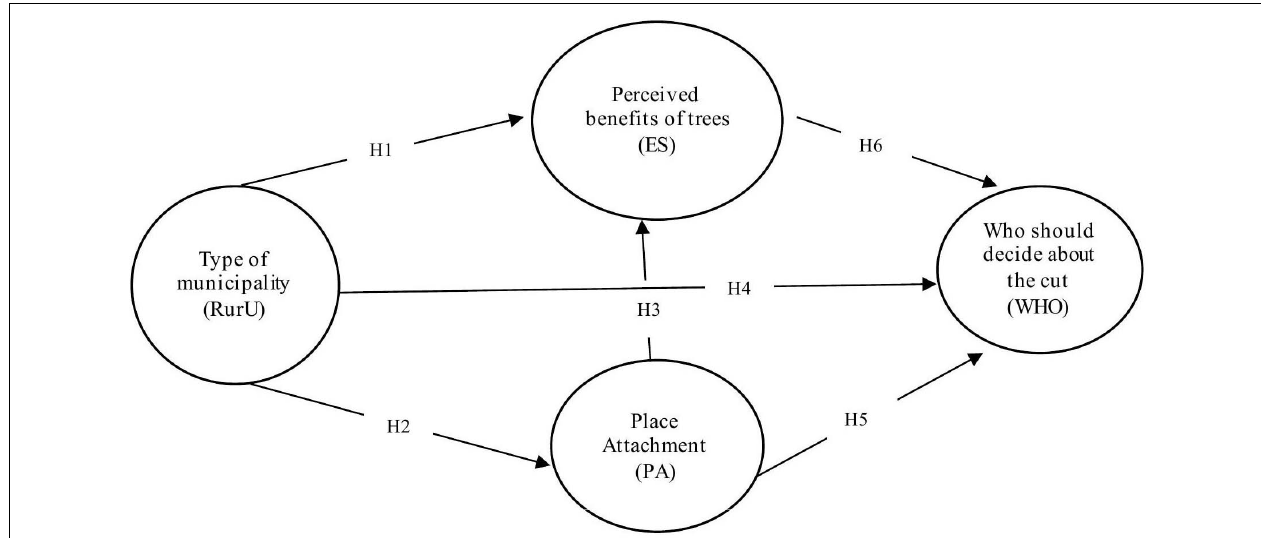
FIGURE 1 | The conceptual model of the